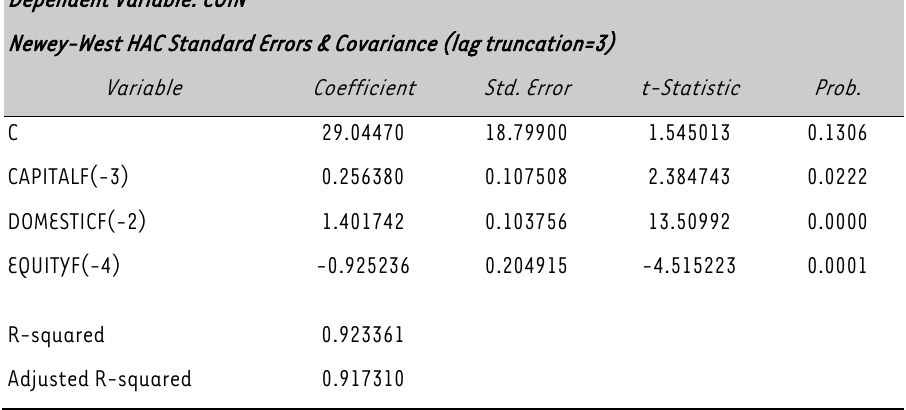
TABLE 5: Regression results for the composite financial indicator Dependent Variable: